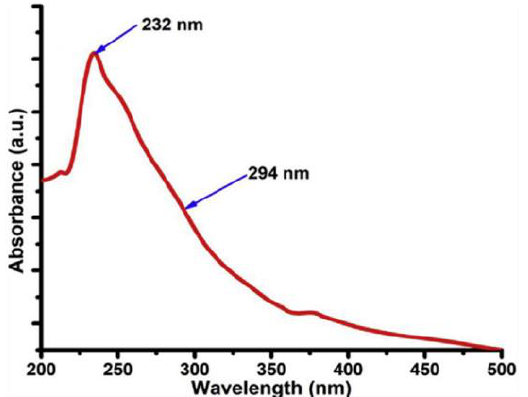
Figure 13. UV-Vis absorbance spectrum of graphene-oxide nanostructures. Reprinted with permis- sion from Ref. [63]. 2019, Elsevier.